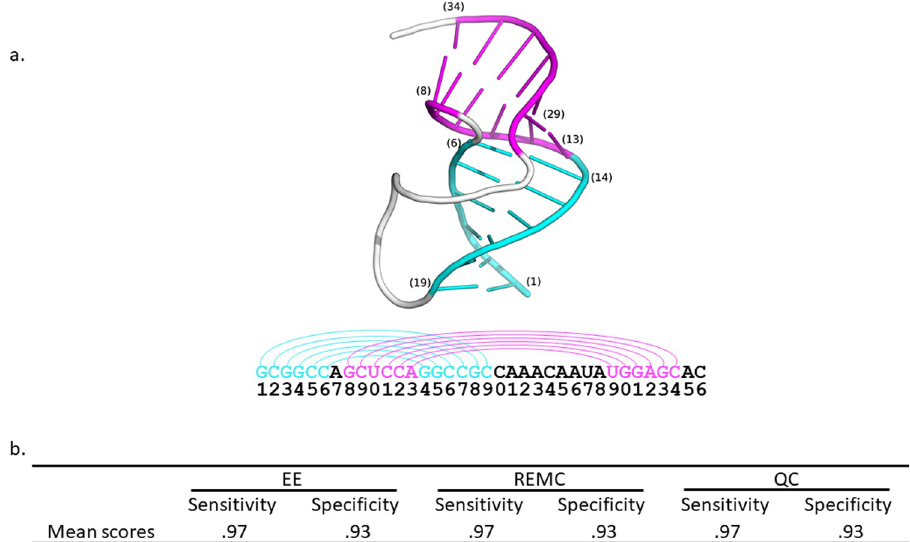
Fig 2. (a) Example RNA sequence from simian retrovirus type-1 (SRV-1) with structure containing pseudoknot correctly predicted by algorithm (PDB code: 1E95). The phosphate backbone is colored white for unpaired bases. (b) Exact Enumeration (EE) was used to compute the sensitivity and specificity of the proposed Hamiltonian (Eq 13) for systems containing 45 stems or fewer. Replica Exchange Monte Carlo (REMC) and quantum computing (QC) methods were tested on the same sequences and were found to exactly recapitulate the lowest energy solutions found by exact